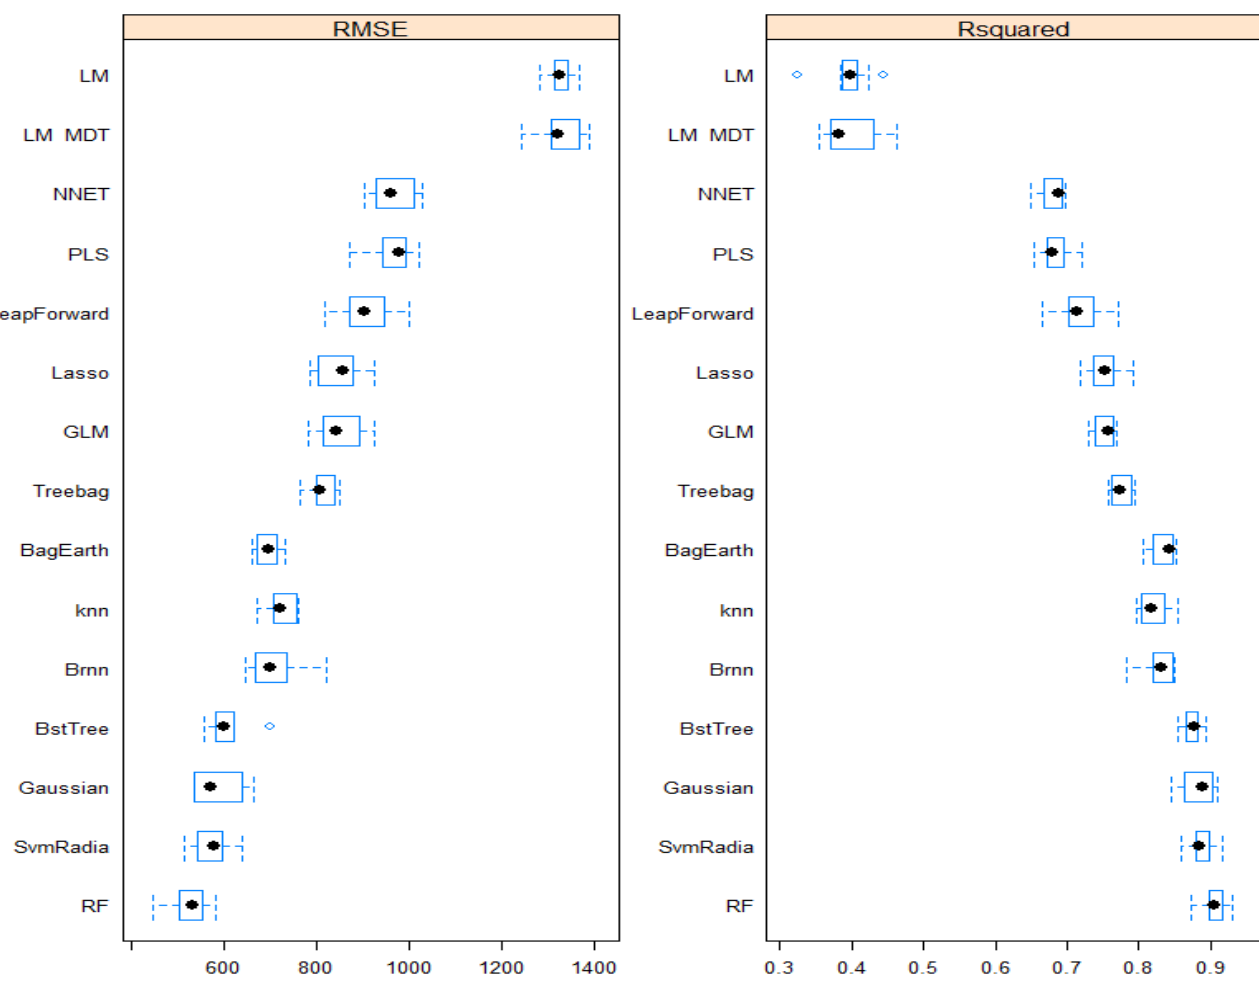
Figure 4. Comparison of the performance of the 15 machine learning algorithms, ordered from lowest to highest R 2 and RMSE (LM = Linear model, LM MDT = Simple linear model with DEM, NNET = Artificial Neural Networks, PLS = Partial Least Squares, LeapForward = Linear Regression with Forward Selection, Lasso = Lasso, GLM = General Lineal Model, Treebag = Bagged CART, BagEarth = Bagged EARTH, knn = k-Nearest Neighbors, Brnn = Bayesian Regularized Neural Networks, BstTree = Boosted Tree, Gaussian = Gaussian Process, SvmRadia = Support Vector Machines with Radial Basis Function Kernel, RF = Random Forest). The mean value of 10 iterations is represented with a black dot, the blue box represents the standard deviation, and the blue lines represent the threshold of the outlier.